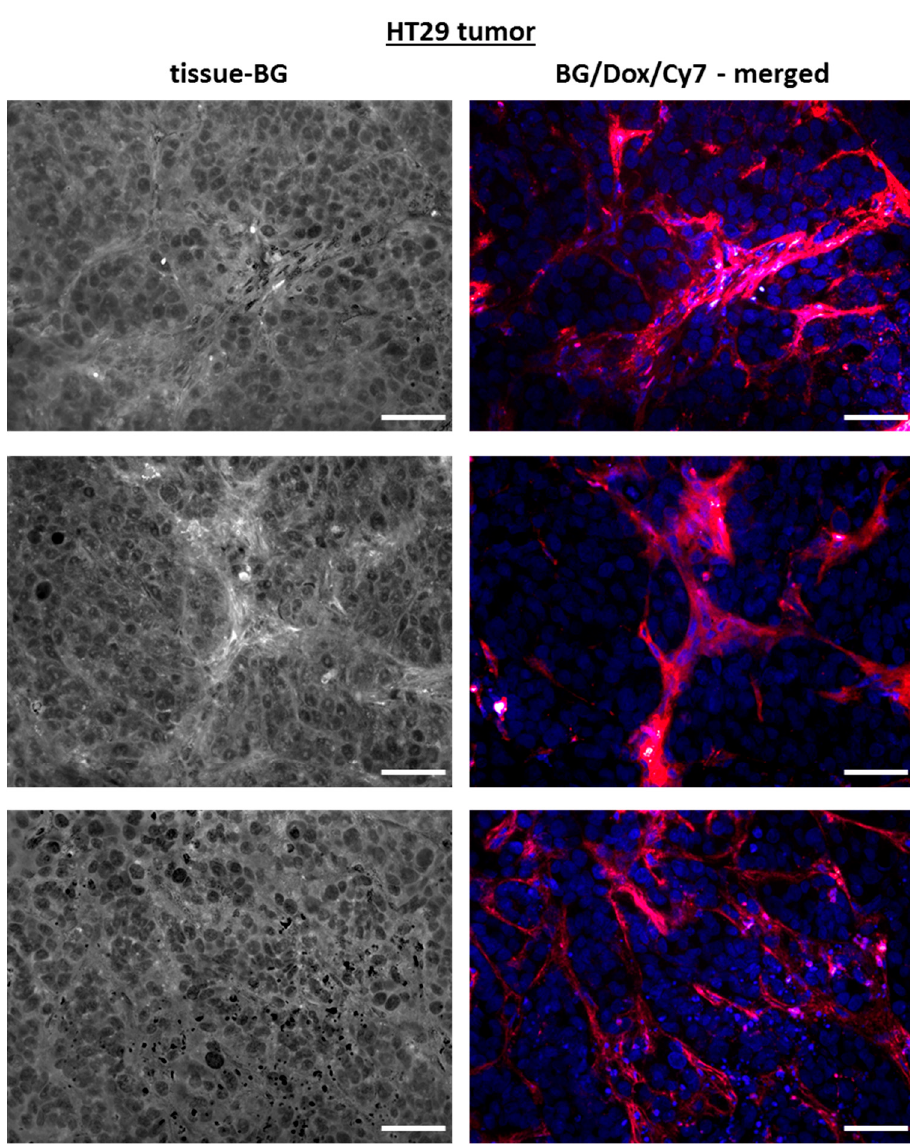
Figure 9. Specific pattern of distribution in the HT29 tumor type. Depicted are three examples representing the main features of distribution found in the HT29 tumor type 24 h after injection of the pHPMA-Dox-Cy7 conjugate. Images on the left side show the tissue background, respectively. On the right side, merged images of isolated Dox (blue) and polymer carrier (red) derived signals are shown, respectively. Intense conjugate- and pure polymer-derived signals are confined to the specific septal connective tissue structures, whereas adjacent tumor cells frequently showed pure Dox accumulation. This suggests a distribution starting from embedded vessels but the entrapment of the polymer and premature release of Dox already within the connective tissue compartment result in the predominant feature of diffusion of pure Dox. Examples with pattern of cytoplasmic polymer can also be found (upper example, bottom right corner). (Scale bar: 50 µm).